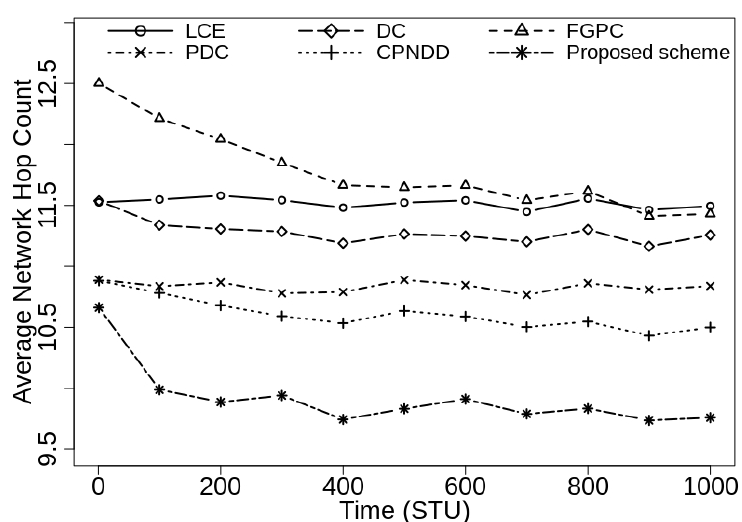
Figure 7. Comparison of average network hop count with λ = 50/s, | CS ( R i ) | = 100, α = 0.7, and | Ctlg | = 5000.